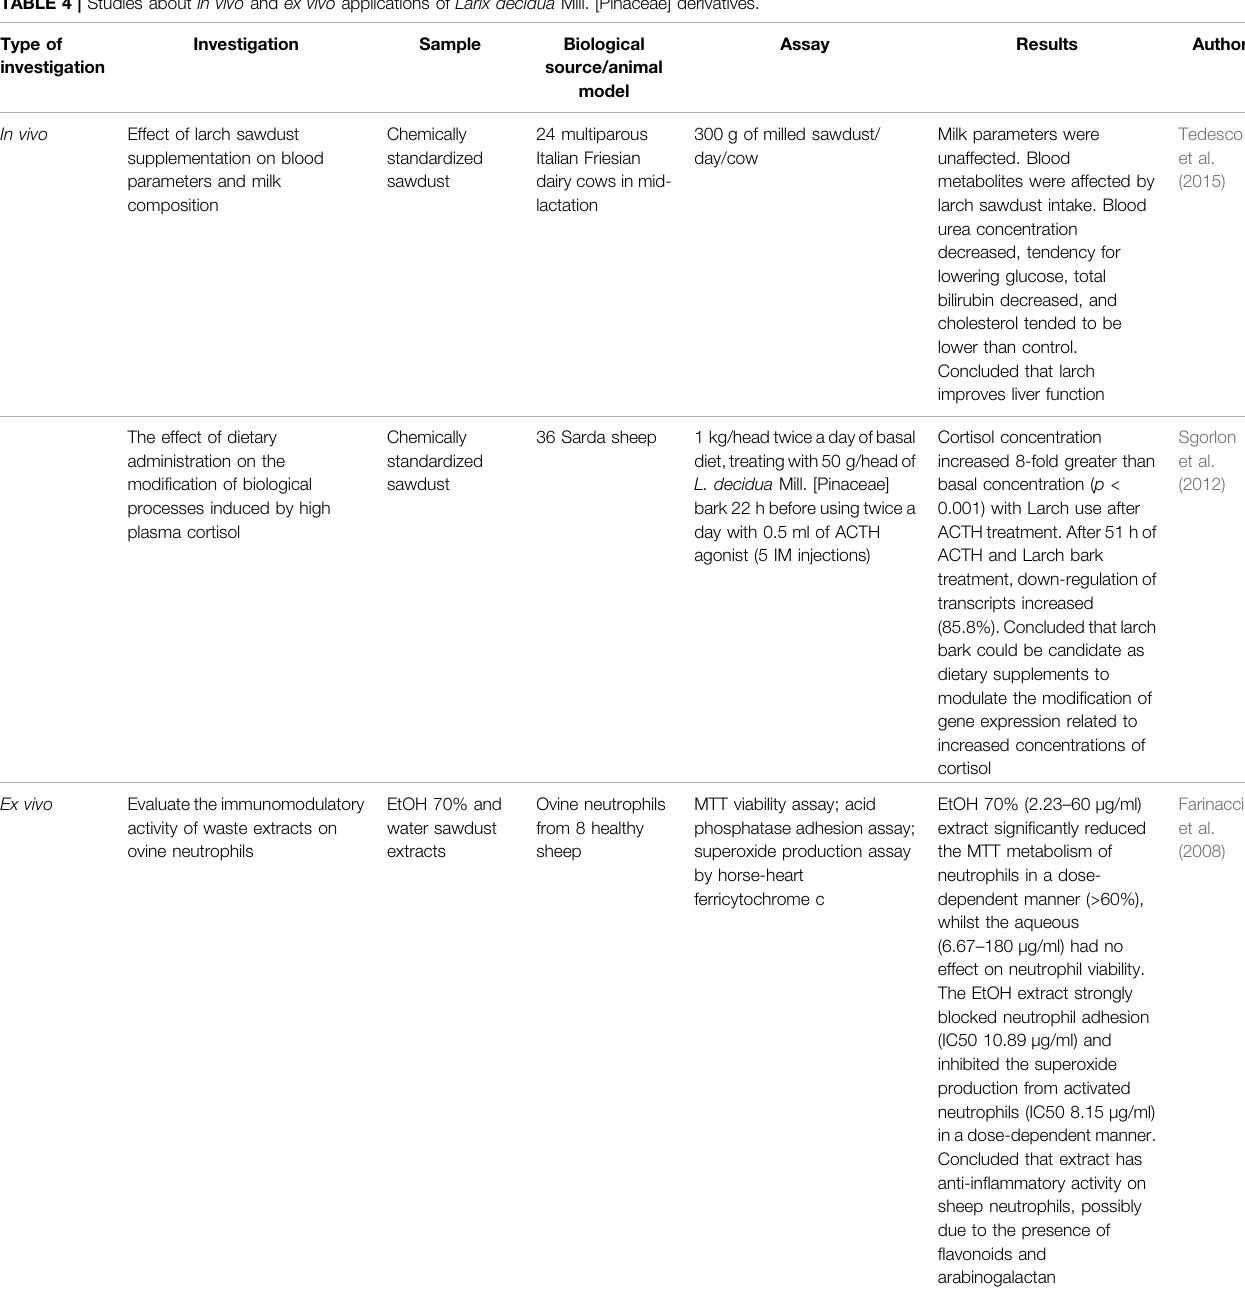
TABLE 4 | Studies about in vivo and ex vivo applications of Larix decidua Mill. [Pinaceae]